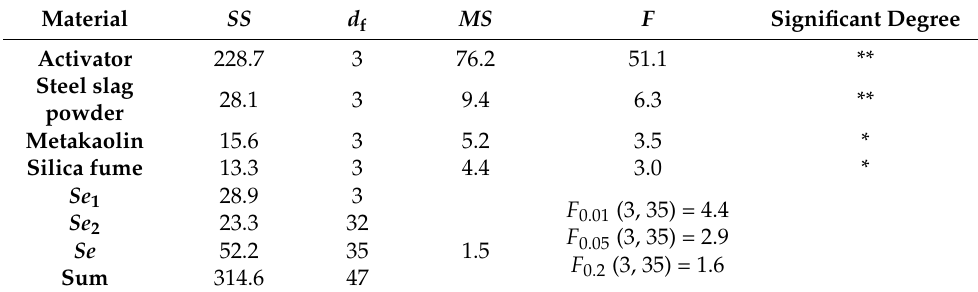
Table 9. Variance analysis of flexural strength.